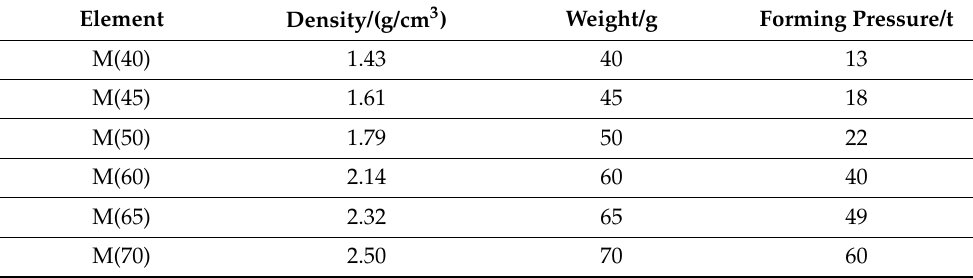
Table 1. MR specimen parameters.